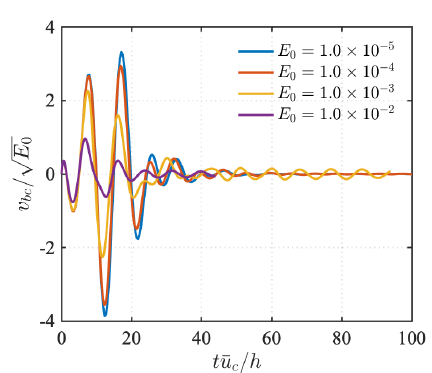
Figure 14. Time history of normalized wall-normal velocity v bc / √ E 0 at the lower wall of the case ( α , β ) = ( 1,1 ) when actuation is turned on.